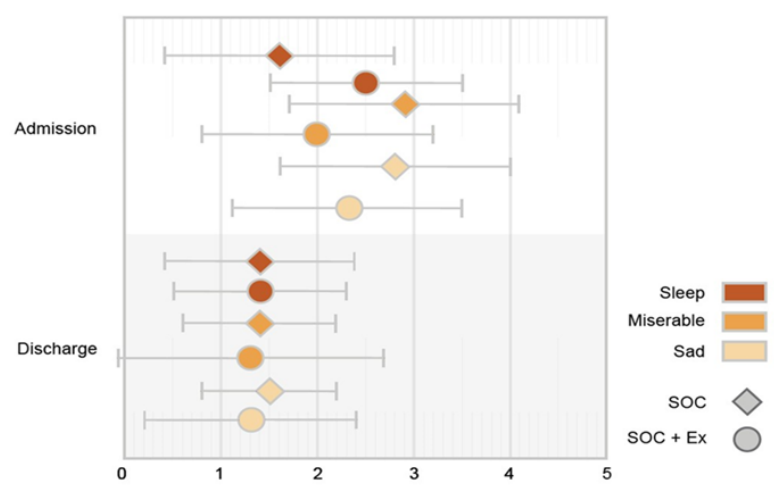
Figure 3. Patient-reported mental item scores at admission and at discharge. Different coloring indicates mental score items: pain, weak, tired. All scores were lower at discharge than admission, indicating improvement ( p < 0.05). Adding exercise had no additional benefits. SOC, standard of care; SOC+Ex, standard of care plus exercise.